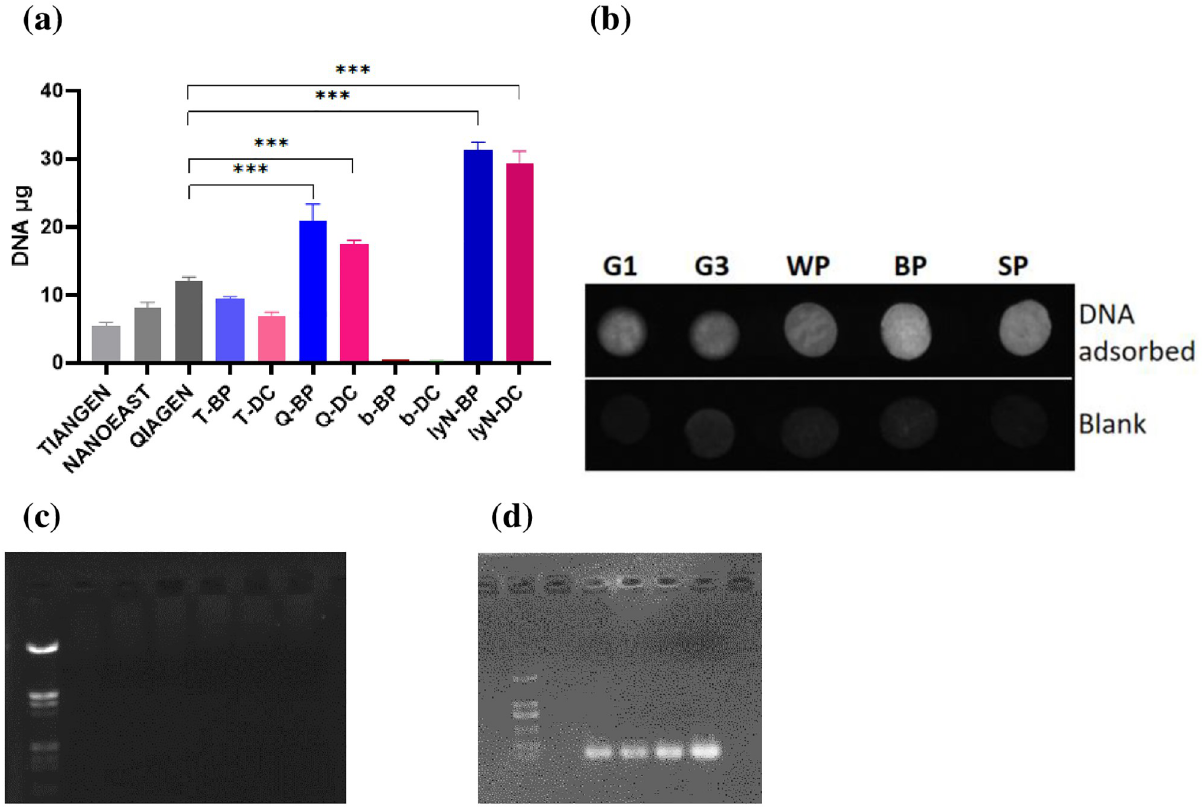
Fig 7. (a) Comparison of the DNA extracting capacities of the current approaches, BP/DC with commercial protocols, and BP/DC with the new protocol. (b) A UV imager was used to compare DNA absorbed utilizing a single piece of PF-BA against blank controls. (c) DNA electrophoresis of the blanks of BP/DC with the new protocol (Marker; BP < n = 3 > ; DC < n = 3 > ). (d) The PCR products of negative control, TIANGEN, NANOEAST, QIAGEN and